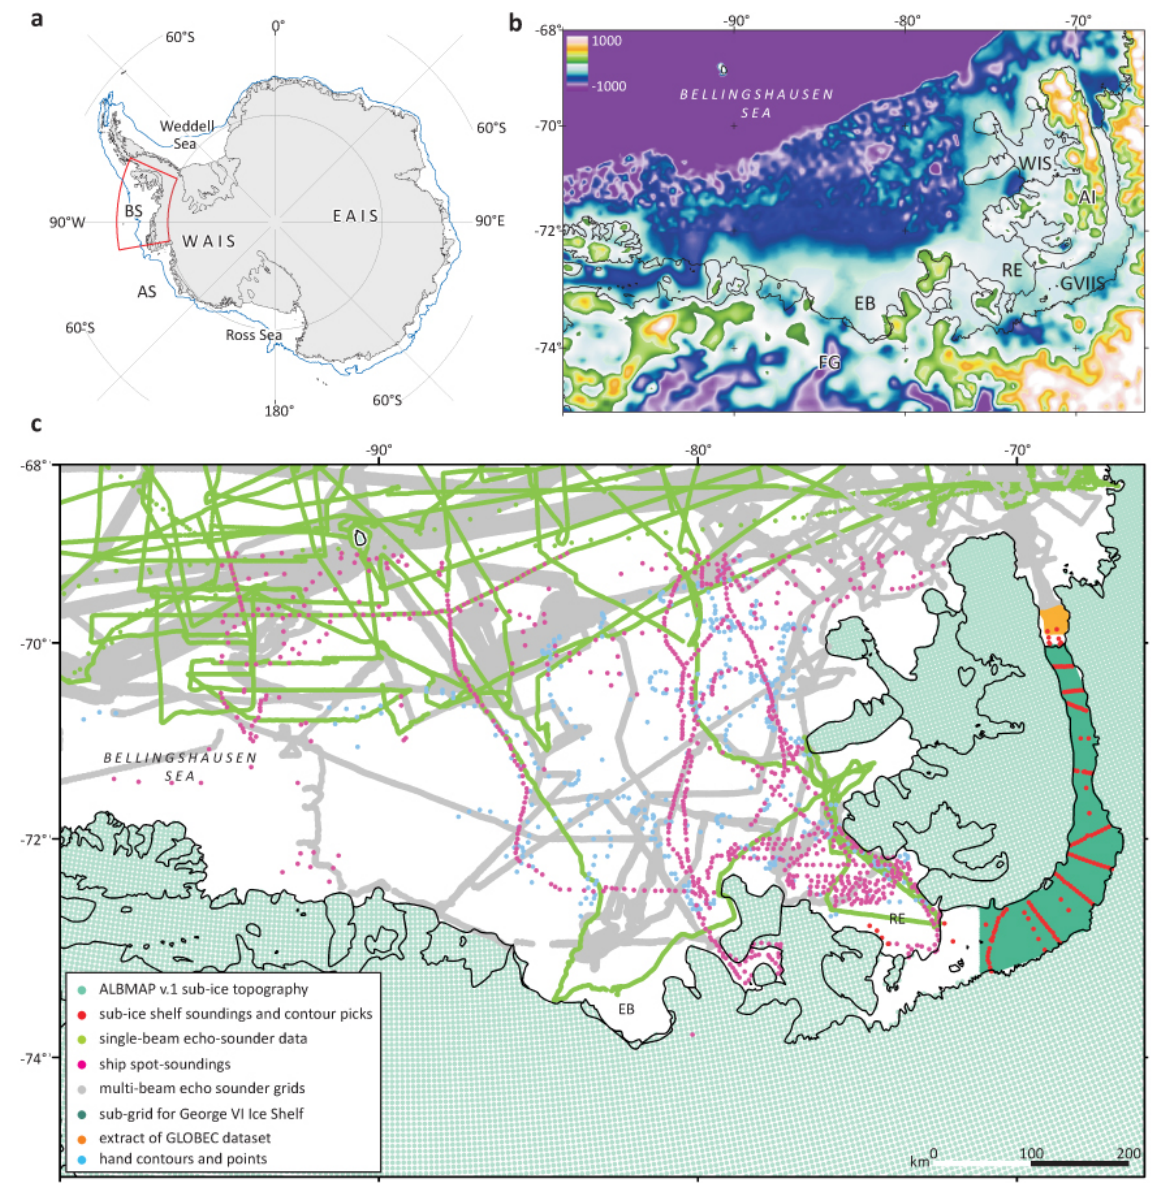
Fig. 1. (a) Location map showing the Antarctic ice sheets, the continental shelf edge (blue) and area covered by the new bathymetry grid (red); South Pole Stereographic projection. (b) Existing bathymetry in the Bellingshausen Sea rendered from ALBMAP v.1.1. (Le Brocq et al., 2010). WGS84 Mercator projection. EB: Eltanin Bay; FG: Ferrigno Glacier; RE: Ronne Entrance; WIS: Wilkins Ice Shelf; AI: Alexander Island; GVIIS: George VI Ice Shelf (c) data types and their distribution for the new bathymetric compilation; coastline drawn from the ADD v.4.1. Table 1 provides additional details. WGS84 Mercator